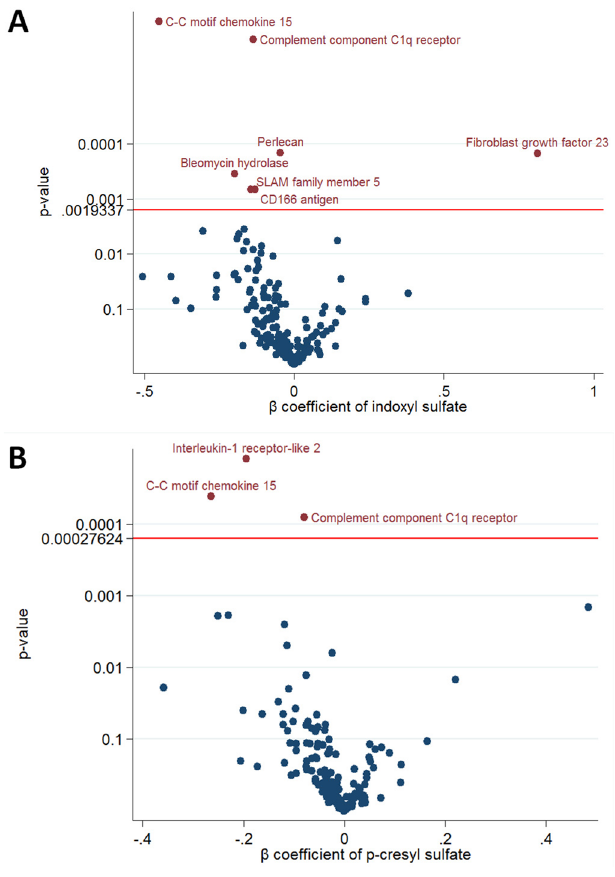
Figure 2. Volcano plot of the p-value and β coefficient for protein-bound uremic toxins and cardiovascular protein biomarkers association with multiple test control. ( A ) Indoxyl sulfate ( B ) p-cresyl sulfate.